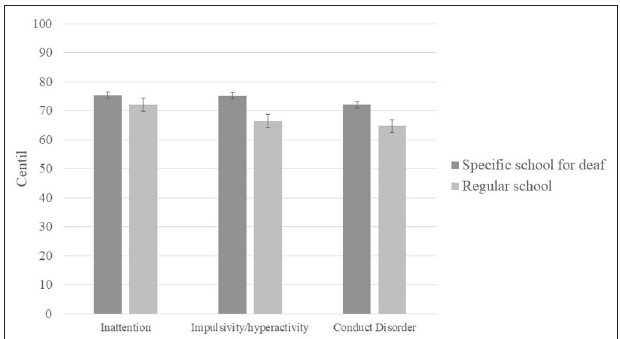
FIGURE 3 | Mean centile scores obtained by deaf children attending a specific school for the deaf and children attending a regular school.